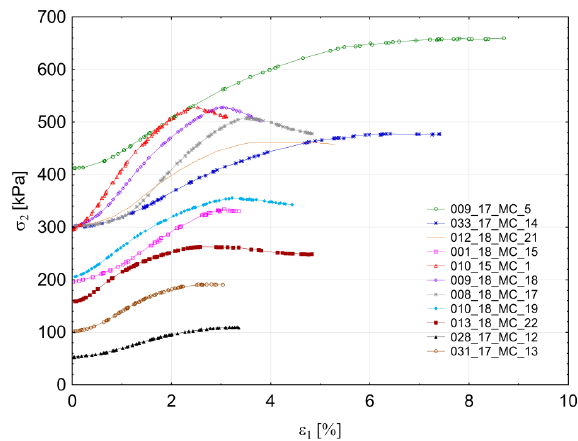
Figure 11: Results of the experimental tests listed in Table 1: volumetric strain as a function of the axial strain e